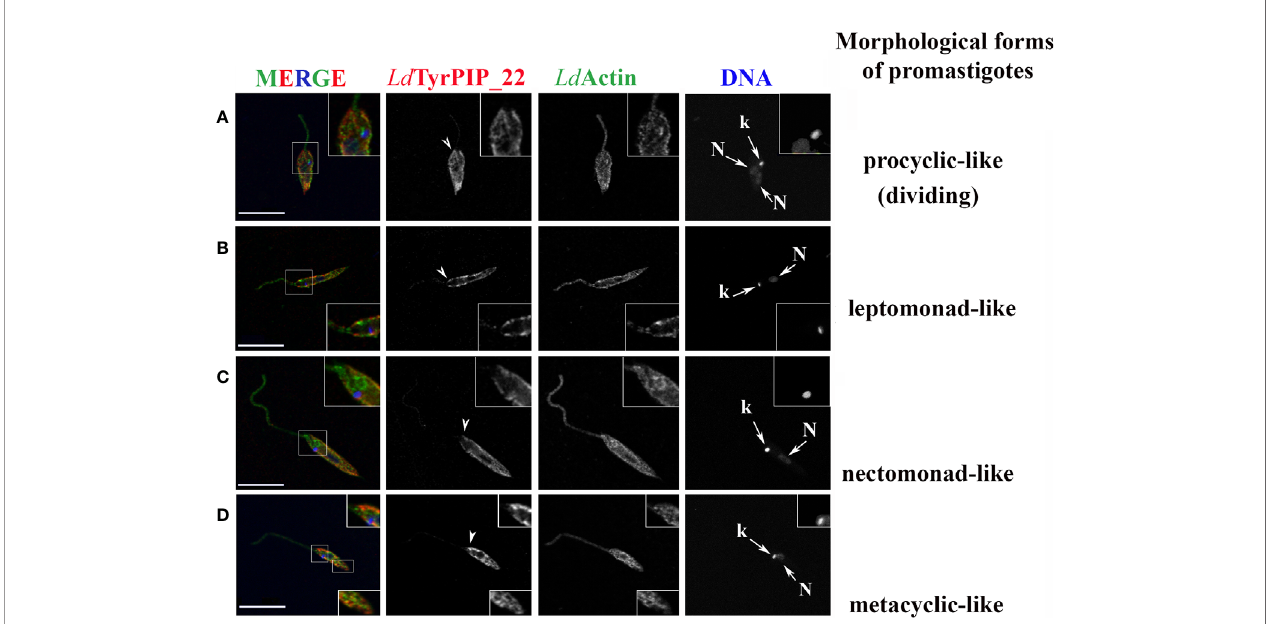
FIGURE 5 | Localization of Ld TyrPIP_22 in different cell cycle dependent morphological forms of cultured L. donovani promastigotes growing at 25°C, pH 7; co staining for Ld Actin. L. donovani promastigotes from logarithmic or stationary phase cultures were fi xed (4% w/v PFA) and permeabilized with 0.1% (v/v) TritonX-100. They were then co stained by IF with the a- Ld TyrPIP_22 mouse pAb (1:250) and rabbit a-LeishActin pAb (1:1,000) followed by secondary Abs conjugated to Alexa Fluor ® 546 and Alexa Fluor ® 488, respectively. Nuclear and kinetoplast DNA was stained with Hoechst 33342 (1:5,000). Representative images of different cell cycle dependent morphological forms of promastigotes were acquired by z-scanning performed at 0.3 m m step size using the TCS SP8 Leica confocal microscope. A single z section with representative staining from each case is shown. Single FL images are shown in black and white (BW) for better contrast while images of the merged FL signals are shown in color. The molecule highlighted in the BW images with single color FL is indicated at the top in the same color as the respective FL signal. Arrowheads point to the fl agellar pocket region/ fl agellum base. Small arrows point to the kinetoplast (k) and nucleus (N). Magni fi cations (1.5-2X) of framed areas are shown as insets. Scale bar size: 10 m